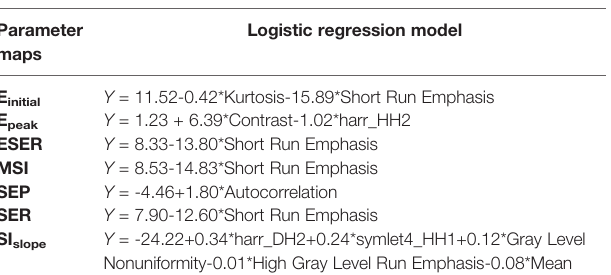
TABLE 4 | Logistic regression models.